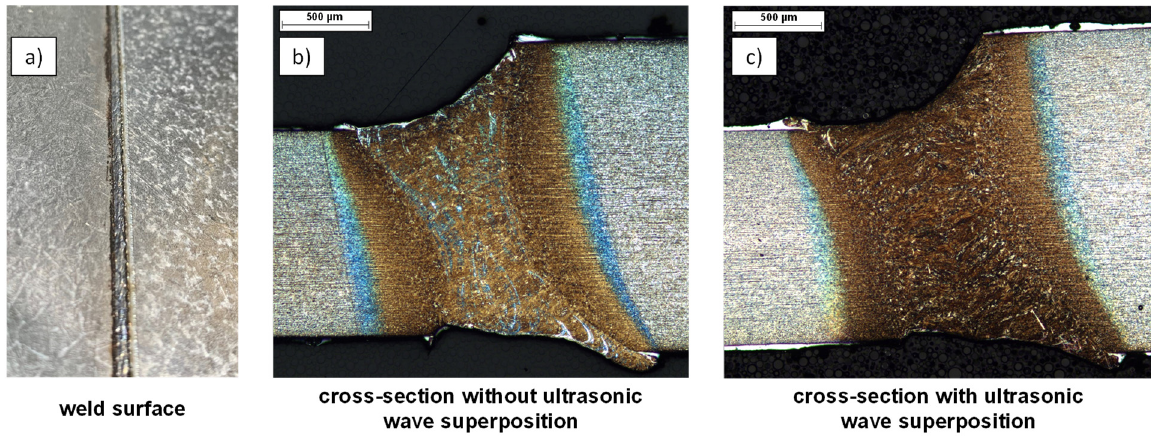
Figure 8. ( a ) Photographic image depicting the surface of laser ‐ welded tailored blanks. ( b , c ) show etched cross ‐ sections to investigate the influence of ultrasonic wave superposition on the distribu ‐ tion of AlSi within the weld metal. of AlSi within the weld